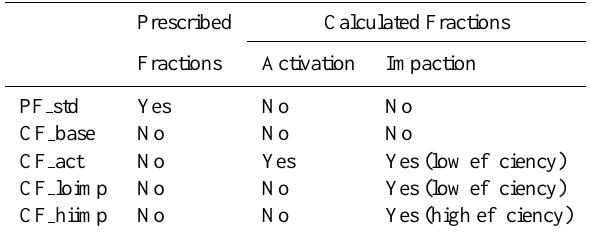
Table 1. Wet scavenging scheme implemented for the aerosols en- trained above convective cloud bases for the five simulations of this study. Note that for the aerosols entering at convective cloud base, all the calculated fraction (CF) simulations allow activation scavenging coupled with the respective impaction scheme applied for the aerosols entrained above cloud base. The prescribed frac- tion (PF) simulation scavenges aerosols entering at convective cloud base with the same prescribed fractions as applied for the aerosols entrained above cloud base. Low and high efficiency refers to the collection efficiency for accumulation and coarse mode aerosol mass.